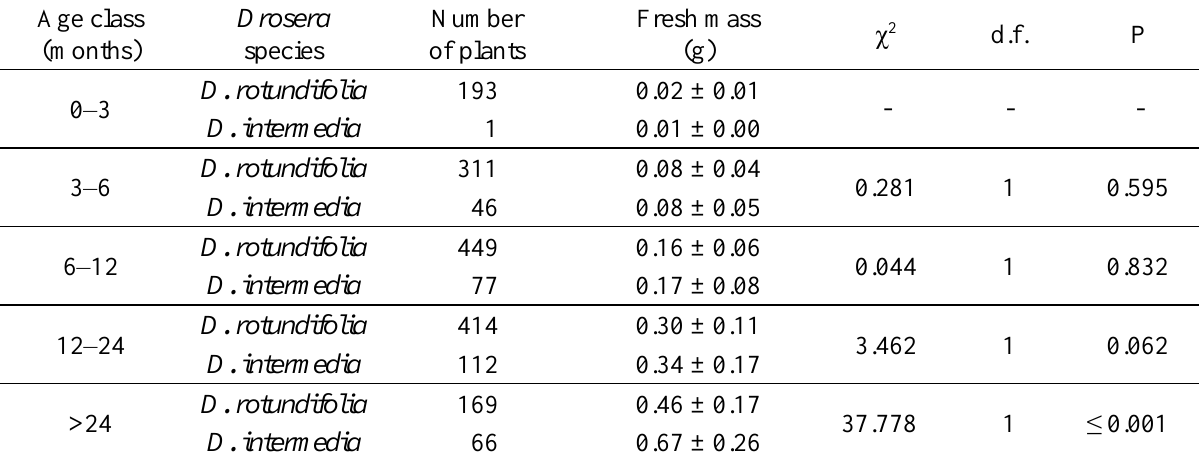
Table A4. Comparison of the mean plant mass (± SD) per age class of Drosera rotundifolia and Drosera intermedia collected in the Sphagnum papillosum field during 2013 and 2014. Test of difference within the P: level of significance. The test was not performed for age class 0–3 months because there were insufficient data for D. intermedia